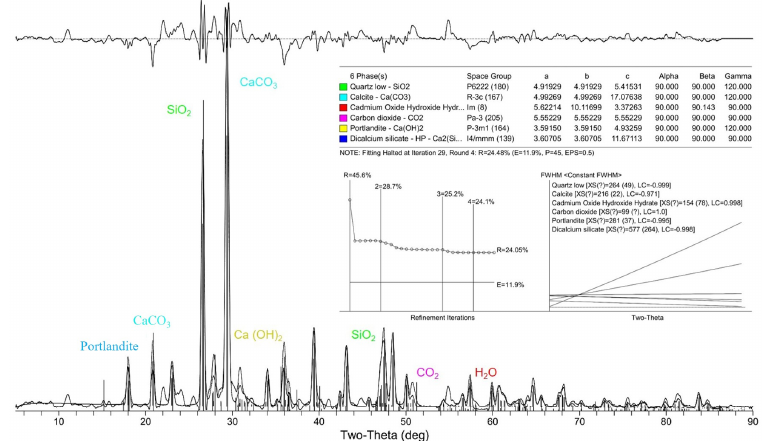
Figure 14. Physical phase analysis of RFA group specimens.